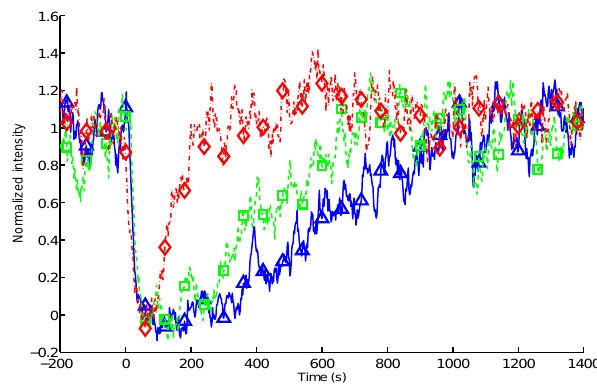
Fig. 3. Breakthrough curves of three CWFT adsorption experiments at 236K (blue triangles), 240K (green squares), and 250K (red di- amonds). The gas flow is led over the CWFT at time=0s. The variation in intensity at 250K ( t = 400–1000s) is due to instrument